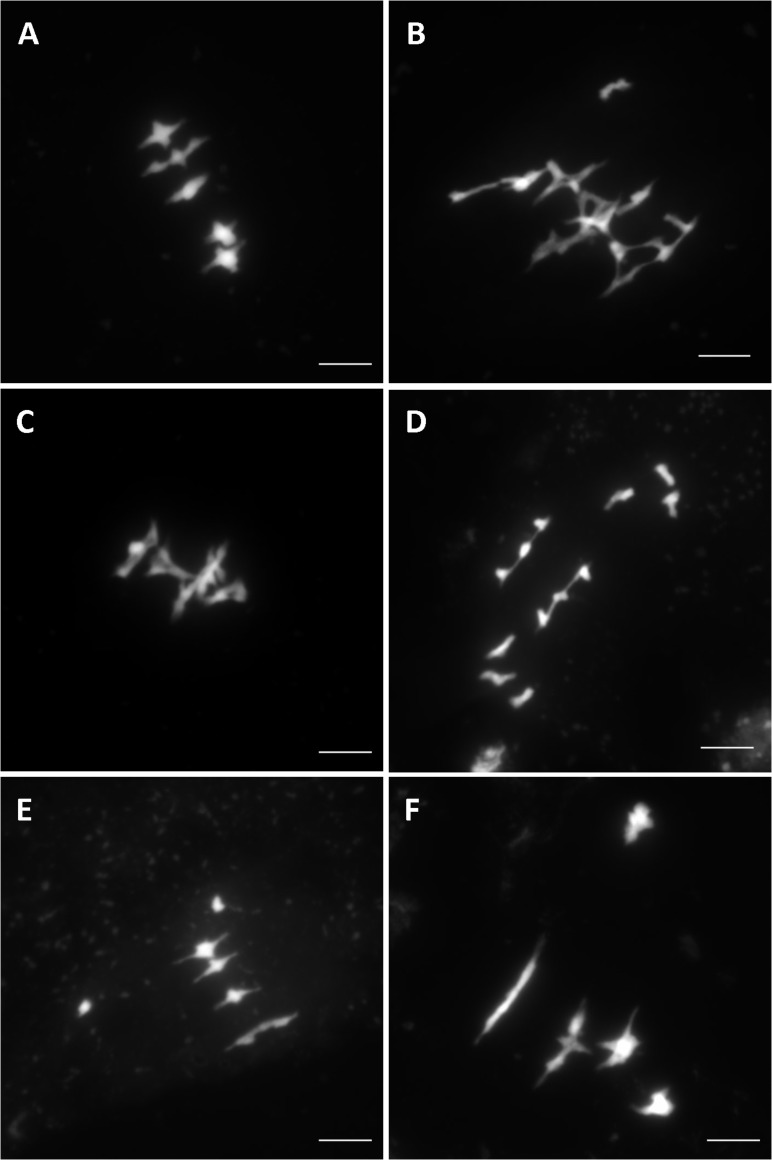
Different meiotic phenotypes observed in the HEM lines at metaphase I showing: (A) Wild type meiosis (B) Chromosome fragmentation, (C) Bivalent shape defects, (D,E) Different levels of univalent chromosomes (ranging from a mean of 6 to 0.1 per cell) and (F) Bivalent alignment defects.